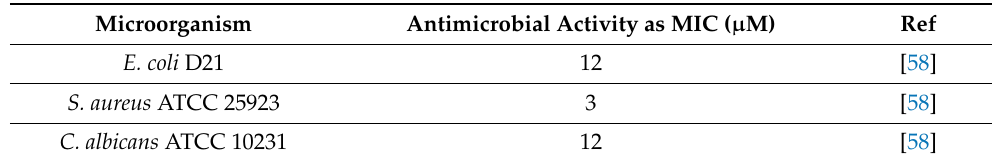
Table 6. Antimicrobial activity against selected microorganisms of peptide temporin